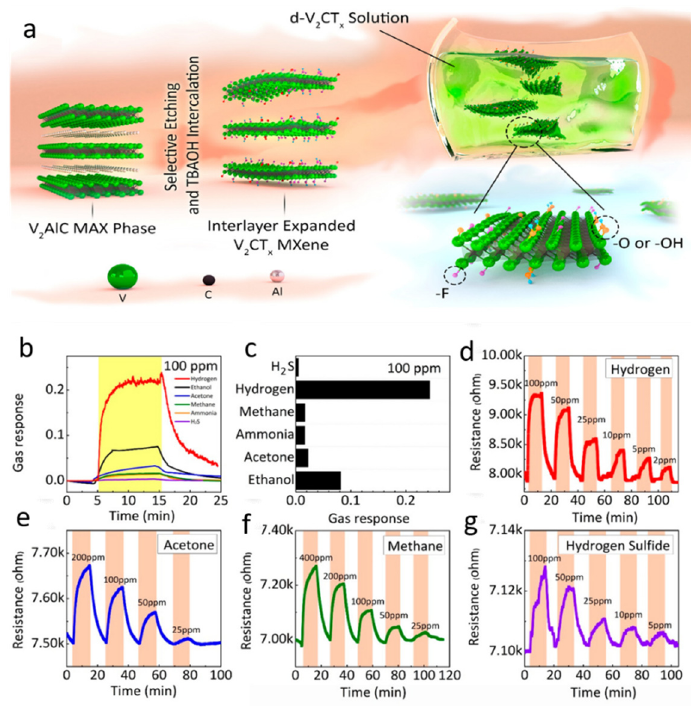
Figure 12. ( a ) Schematic for the delamination of V 2 CT x MXene. ( b ) The compiled resistance variation of the V 2 CT x gas sensor toward 100 ppm gases at room temperature. ( c ) Sensor response toward 100 ppm of hydrogen sulfide, hydrogen, methane, ammonia, acetone, and ethanol at room temperature. Real-time sensing response of the V 2 CT x sensor toward varying concentrations of different gases: ( d ) Hydrogen, ( e ) acetone, ( f ) methane, and ( g ) H 2 S. Reproduced with permission from ref. [156] Copyright 2019, the American Chemical Society.